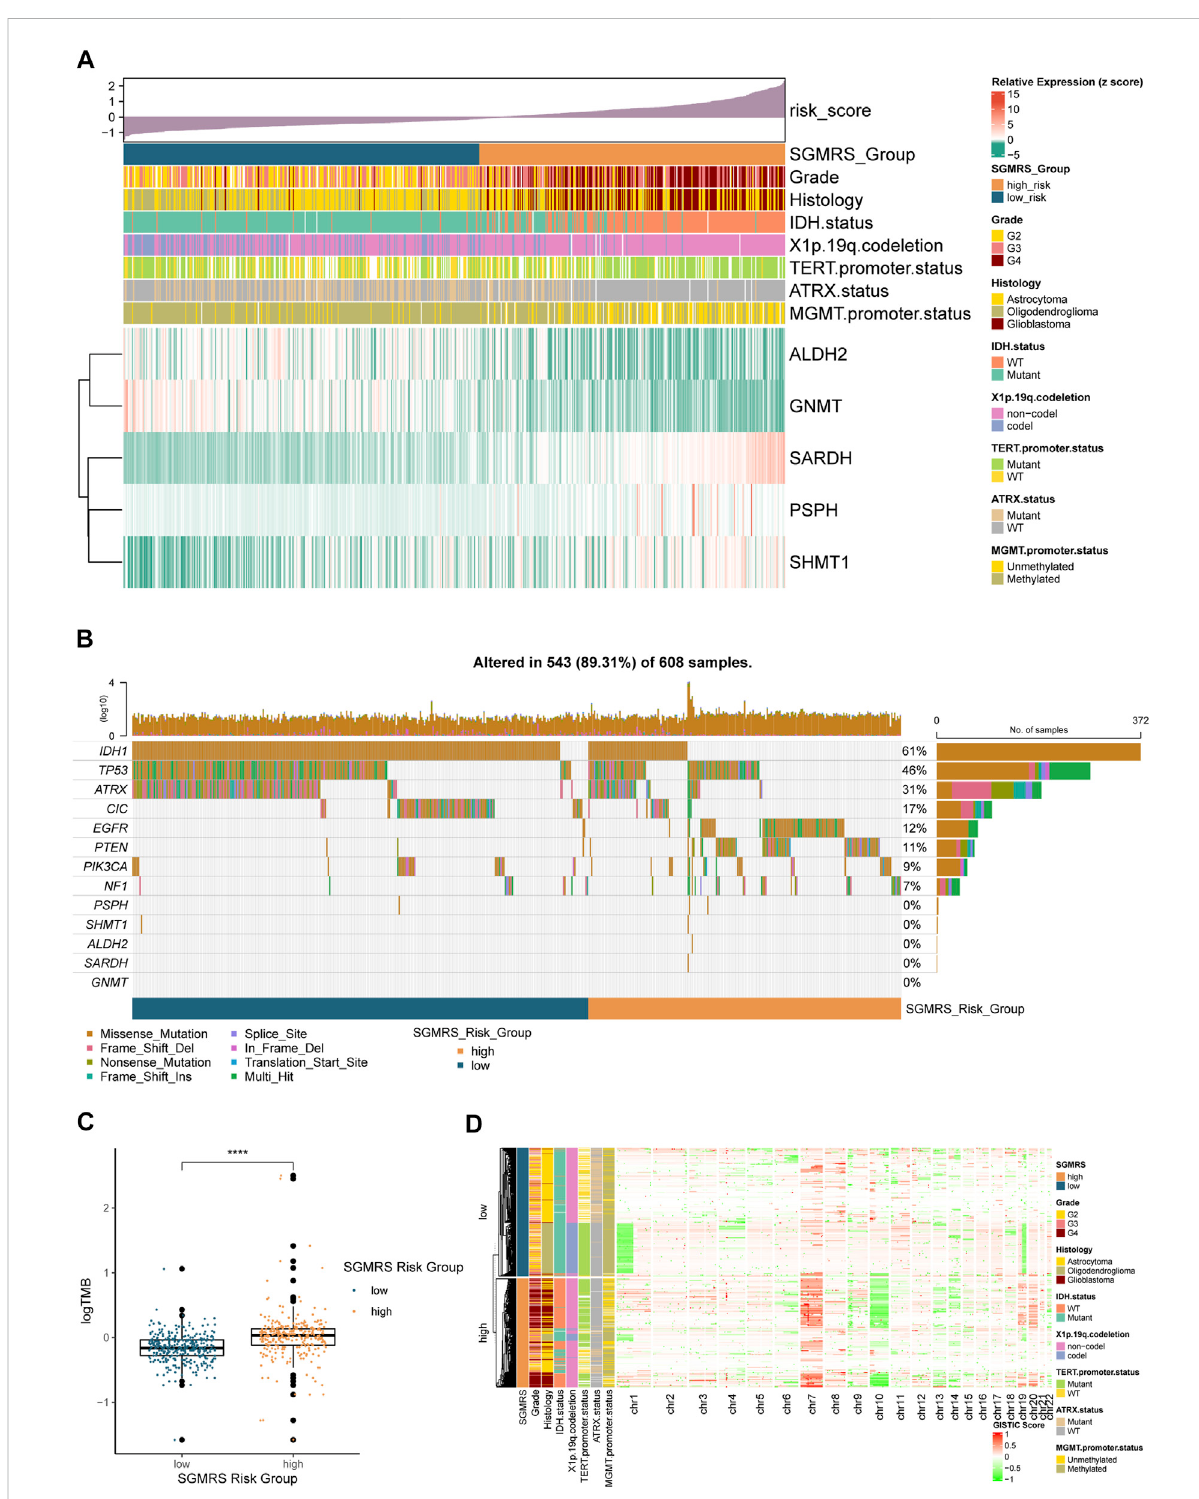
FIGURE 5 Clinicopathological features of SGMRS risk groups. (A) Expression level of fi ve critical SGMGs and its relationship with clinicopathological features. (B) Gene mutations of fi ve critical SGMGs and top eight frequently mutated genes in gliomas ordered by SGMRS risk groups. (C) Difference in tumor mutation burden between SGMRS high- and low-risk groups. (D) Copy number variation and its relationship with clinicopathological features ordered by SGMRS risk groups. * p < 0.05; ** p < 0.01; *** p < 0.001; **** p <